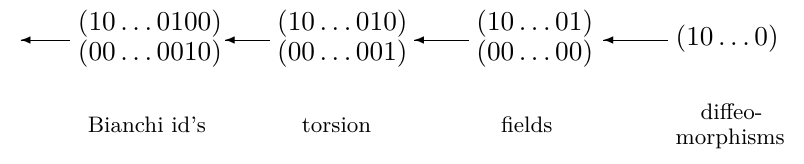
Figure 1 . The W ( d ) complex of